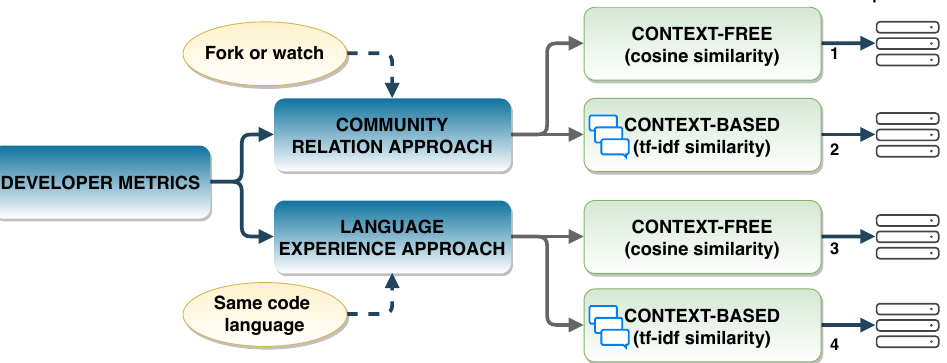
Figure 7. The hit scores calculations with 4 different parameters